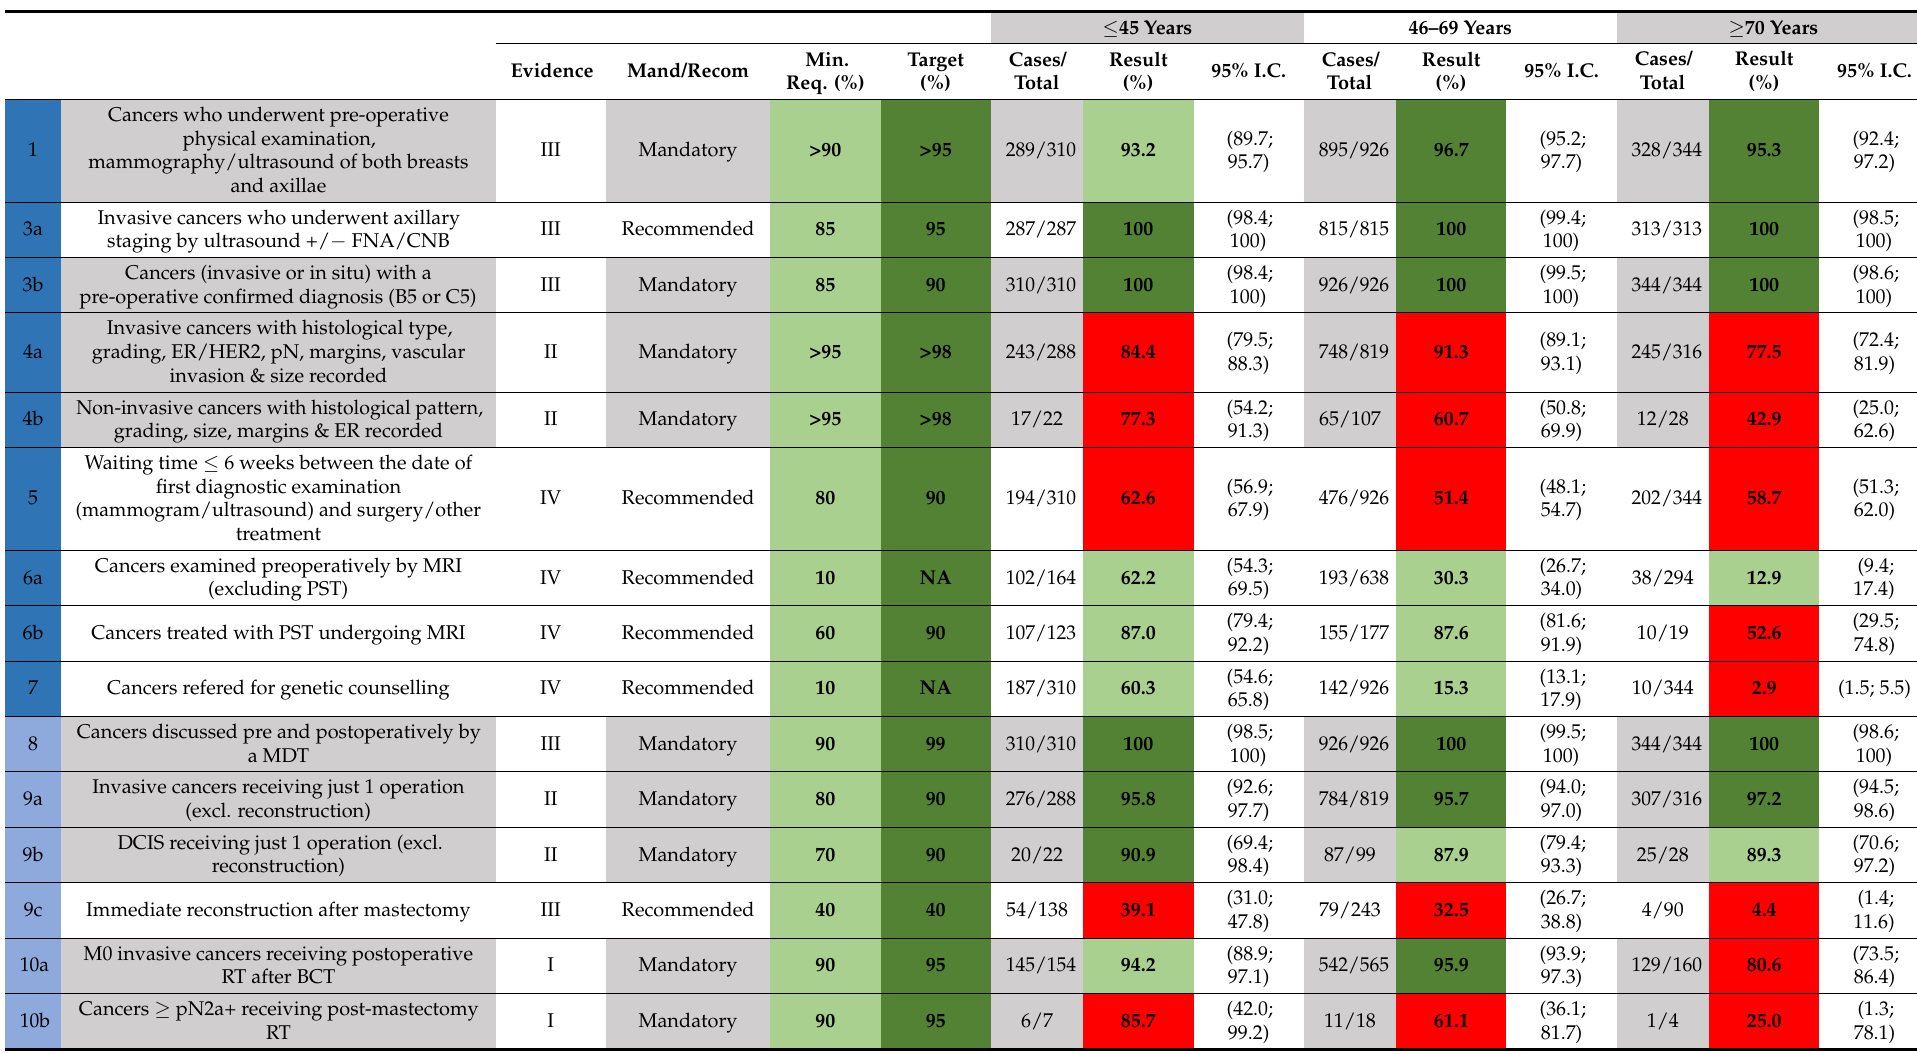
Table 2. EUSOMA Quality Indicators compliance by age